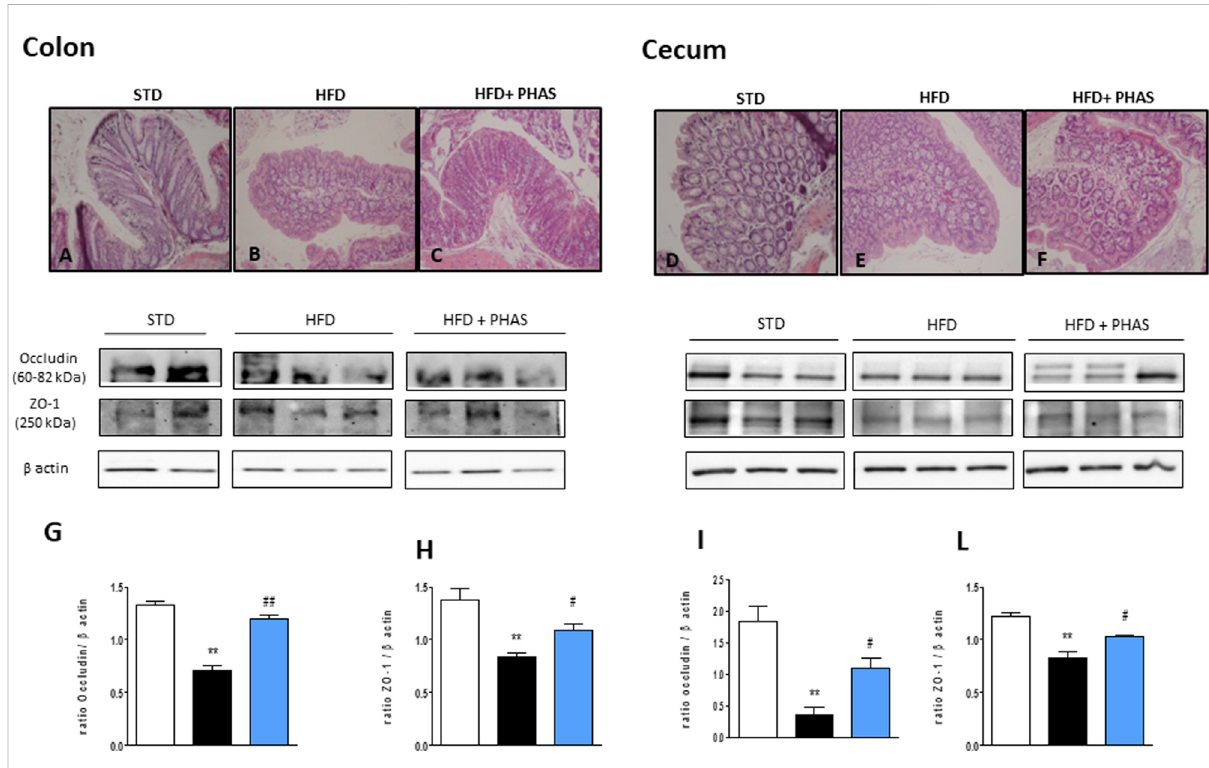
FIGURE 5 Histological changes of hematoxylin-eosin staining assay in colonic and cecum tissue in HFD mice induced by P. vulgaris extract (500 mg/kg, PHAS 500) treatment. Micrographs are representative pictures with an original magni fi cation of ×20 (n = 4). (A) Colon tissue from the control group. (B) ColontissueofHFDmice,showingseveregobletcellhyperplasiaandmildepithelialhyperplasiawithlow-gradedysplasia. (C) Colontissue of HFD + PHAS group, showing moderate goblet cell hyperplasia. (D) Cecum tissuefrom control mice. (E) Cecum tissueof HFD mice, showing severe goblet cell hyperplasia and mild epithelial hyperplasia with low-grade dysplasia. (F) Cecum tissue of HFD + PHAS group, showing moderate goblet cellhyperplasia. Protectiveeffectof P.vulgaris extract (500 mg/kg,PHAS 500)treatmentoncolonic andcecumbarrierintegrityinHFD mice: in particular, immunoblot representatives of occludin expression in the colon (G) and cecum (I) and ZO-1 in the colon (H) and cecum (L) were showed.Thelevelsareexpressedasthedensityratiooftargetto β -actin.Dataareexpressedasmeans±SEM( n =6).** p < 0.01vs.STD;# p < 0.05and ## p < 0.01 vs.